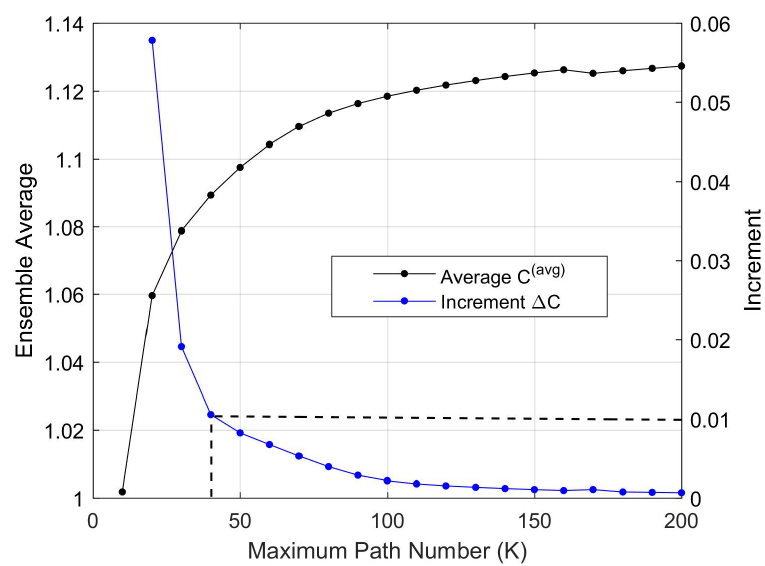
Figure 10. Normalized reliability values and increments for varying K